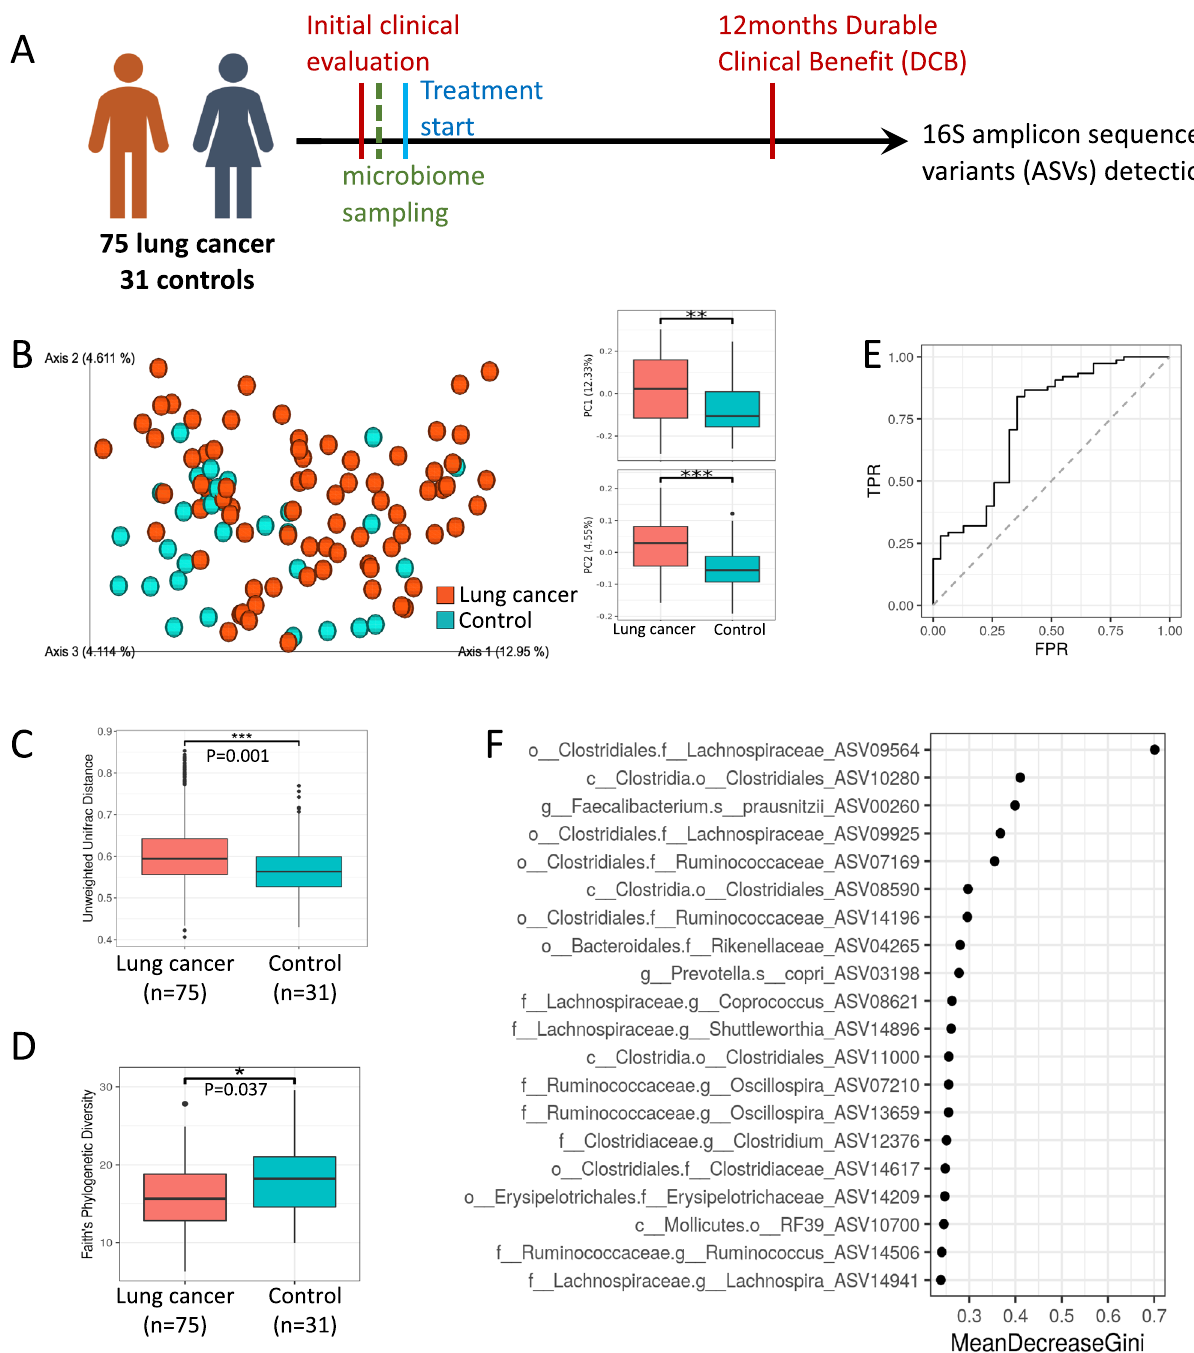
Figure 1. Gut microbial composition is altered in patients with lung cancer (LC). ( A ) Scheme of samples collected design. 106 subjects (75 LC patients and 31 controls) submitted pretreatment fecal samples and had V4 16S amplicon sequencing. ( B ) Unweighted UniFrac PcoA plots colored by disease/healthy (left) and boxplots demonstrating the PC1 and PC2 separation of the groups (right). ( C ) Unweighted UniFrac β-diversity within LC and controls is plotted by diagnosis using only one sample (first sample)/subject (PERMANOVA test, p = 0.001, 999 permutations). ( D ) α-diversity (Faith’s phylogenetic diversity) plotted by diagnosis using only one sample/subject (Mann–Whitney, p = 0.037). ( E ) and ( F ) Random Forest machine learning classification of LC cases from controls using gut microbiome dataset. ( E ) ROC curve of random forest result, differentiating between 75 LC and 31 age matched controls, with an AUC of 0.74. ( F) Top 20 ASVs used for the random forest result differentiating between 75 LC and 31 age-matched controls (Full list in Dataset S2). Box and whisker plots ( C – D ) with central line indicating median, box margins representing upper and lower interquartile region (IQR), and whisker indicates additional